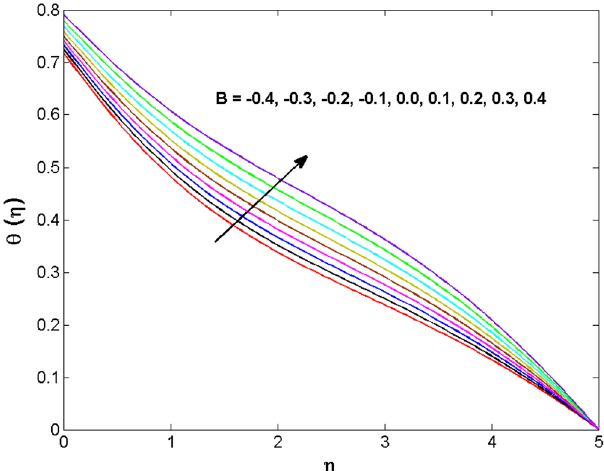
Figure 13. Variations of B to θ (η) .